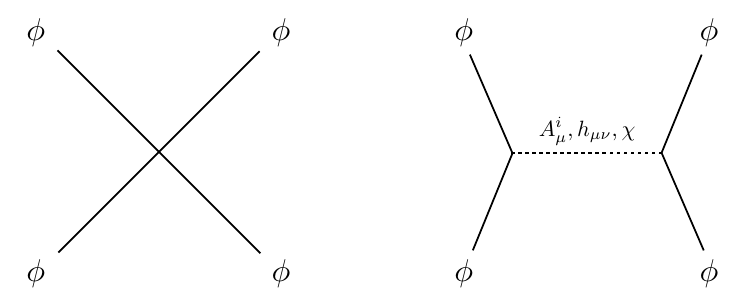
Figure 1 . Feynman diagrams for four-point interactions at tree-level: point-like, as φ 4 , φ 2 ( ∂φ ) 2 , . . . (left), or mediated by gauge bosons A i (e.g., photons), graviton or neutral scalar χ µ